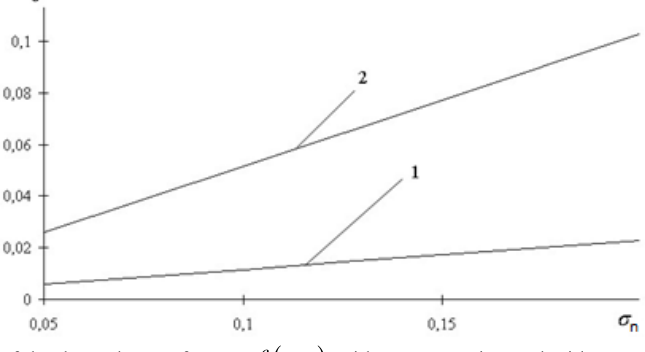
f   with compensation and without compensation Fig. 8. Graphs of the dependence of   0 n of the approximation error (uniform distribution